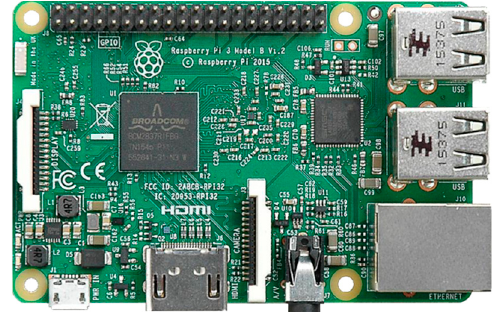
Figure 6. Raspberry Pi 3.